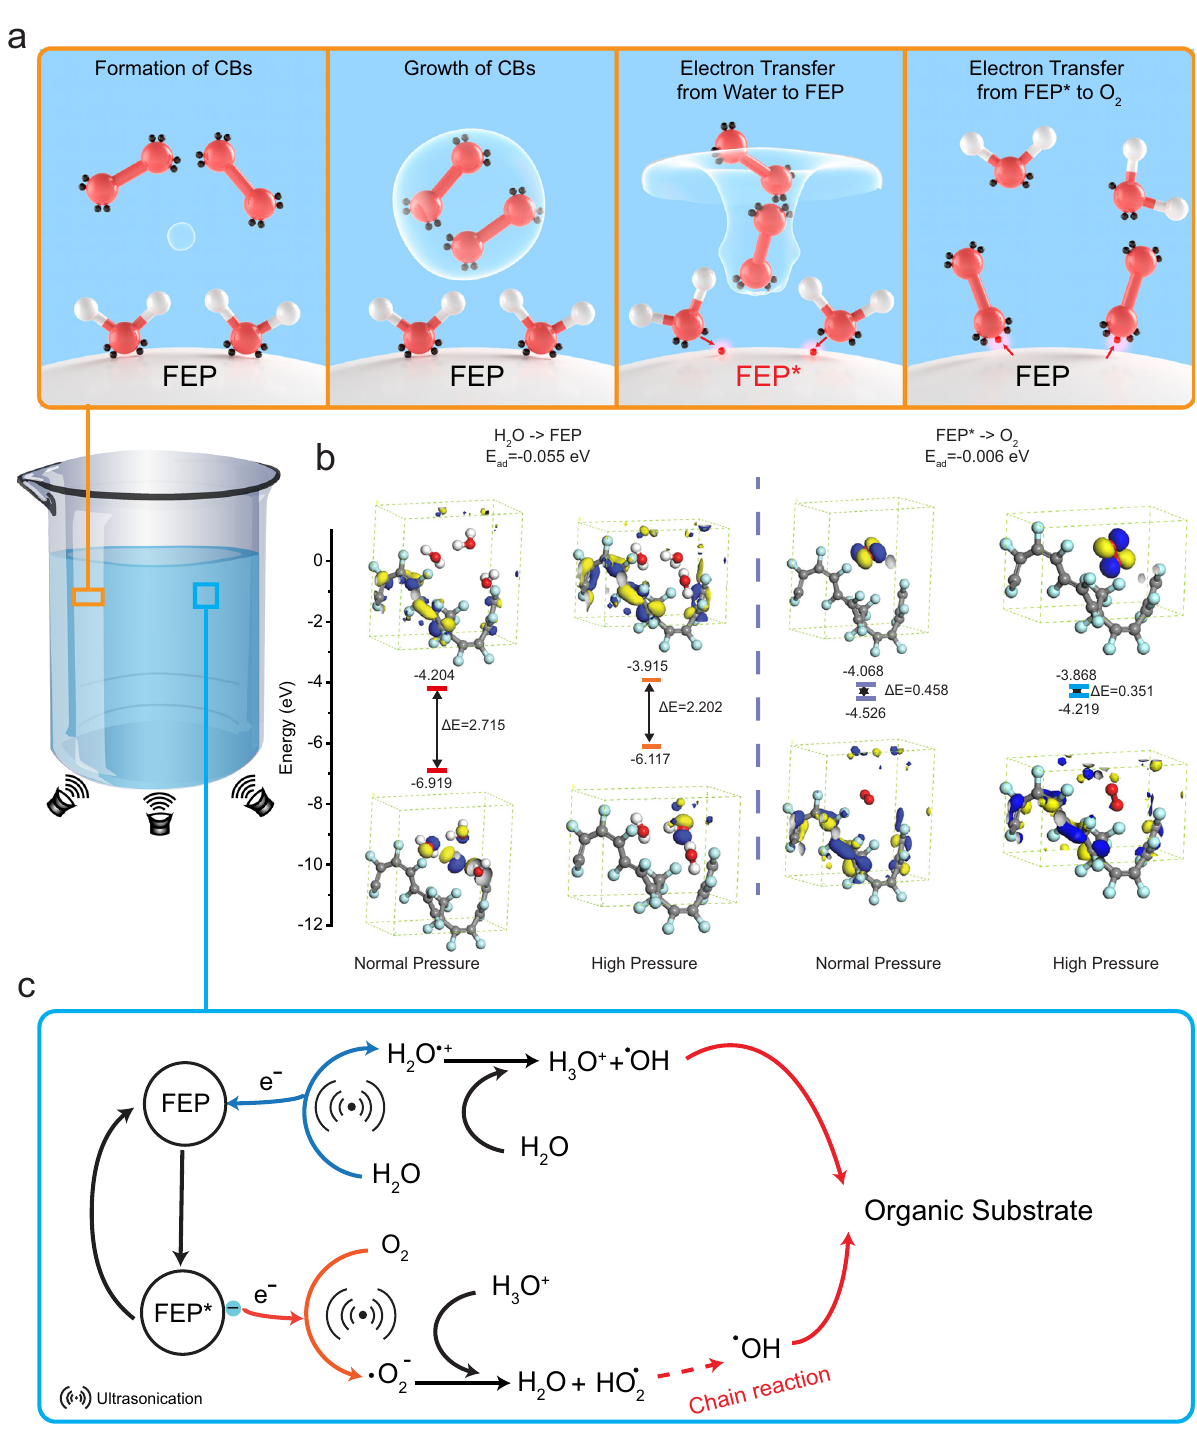
Fig. 4 Mechanism of contact-electro-catalysis. a Schematic representing the contact-electro-catalysis phenomenon during ultrasonication. The red sphere represents the oxygen atom, while the white for a hydrogen atom, and black for electrons. b DFT calculations of the values of LUMO and HOMO levels for Water-FEP and O2-FEP in various conditions as indicated by the legend. c Proposed mechanism for the degradation of MO by contact-electro-catalysis generated